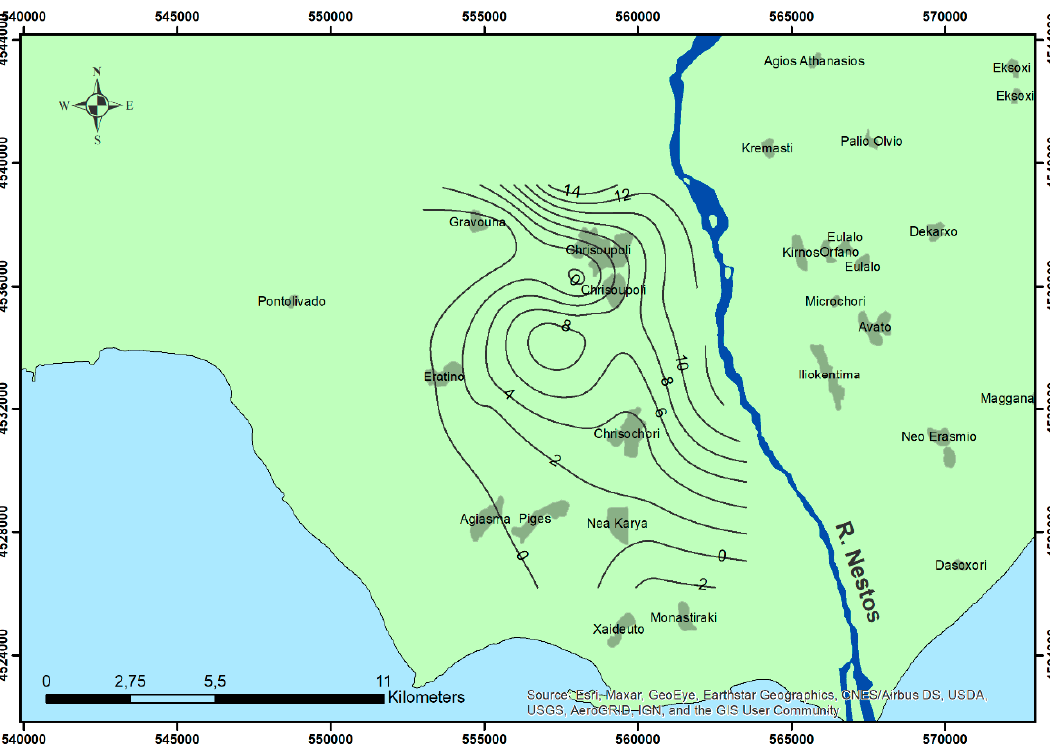
Figure 7. Piezometric map of the confined aquifer (May 2019).